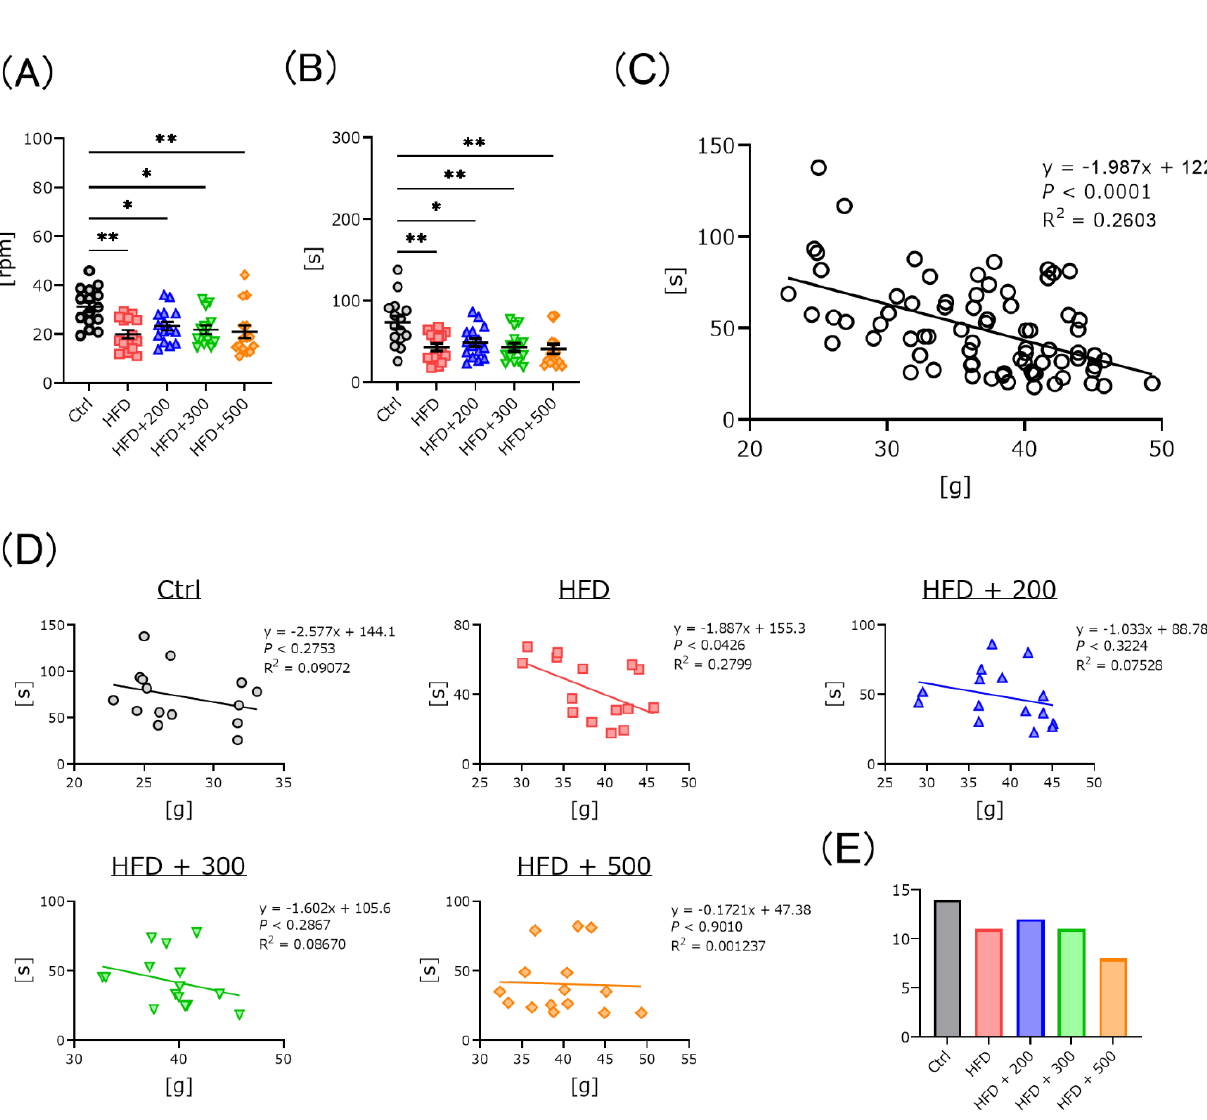
Figure 2. Time to fall in the rota-rod test. The fall speed and fall time are shown in panels ( A ) and ( B ). The relationship between weight and time to fall from the rod for all mice is shown in panel ( C ). The relationship between weight and time to fall from the rod for each mouse group is shown in panel ( D ). Panel ( E ) shows the number of mice that have remained on the rod for more than 30 s. Control (Ctrl, n = 15), high fat diet (HFD, n = 15), HFD + DSW-extract-added water hardness 200 (HFD + 200, n = 15), HFD + DSW-extract-added water hardness 300 (HFD + 300, n = 15), HFD + DSW-extract-added water hardness 500 (HFD + 500, n = 15). * p < 0.05, ** p < 0.01. The data are shown as means ± SE. Statistical analysis of data in panels A and B was performed using the Tukey-Kramer method. Those for panels ( C ) and ( D ) were performed using simple regression analysis.